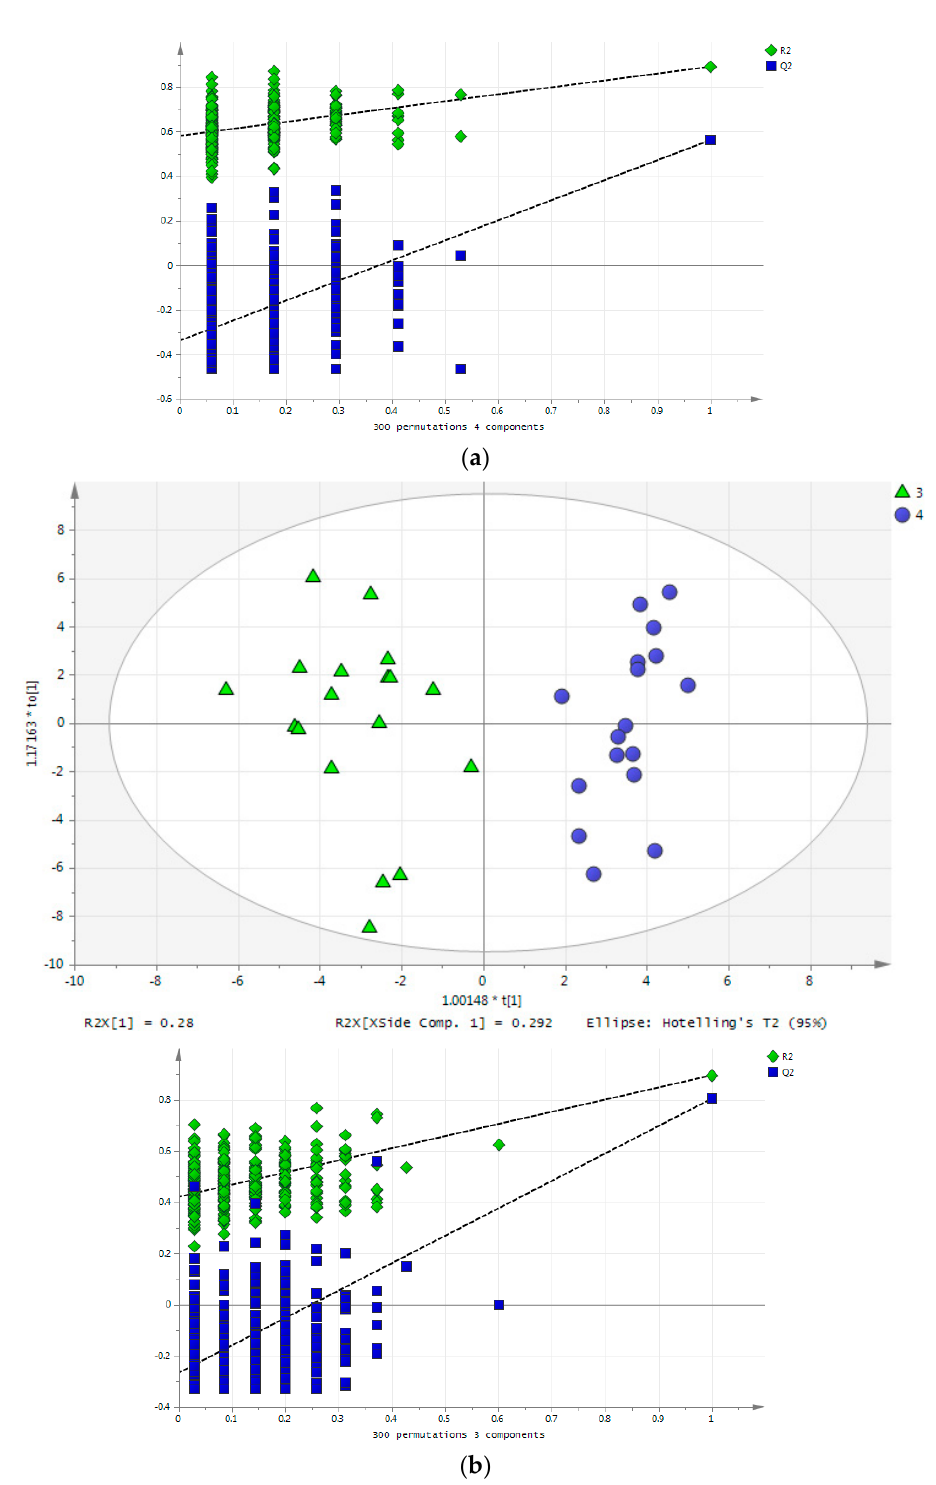
Figure 6. ( a ) OPLS-DA scores plot of rat whole blood samples of sedentary group A (blue) and exercise group B (green) at the first sampling time point. The permutation plot demonstrates a statistically significantly model; ( b ) OPLS-DA scores plot of rat whole blood samples of sedentary group A (blue) and exercise group B (green) at the second sampling time point. The permutation plot demonstrates a statistically significantly model.